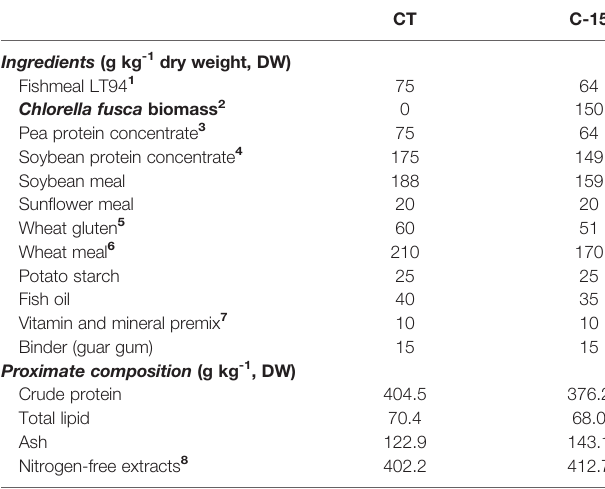
TABLE 1 | Ingredient composition of the experimental diets used in the feeding